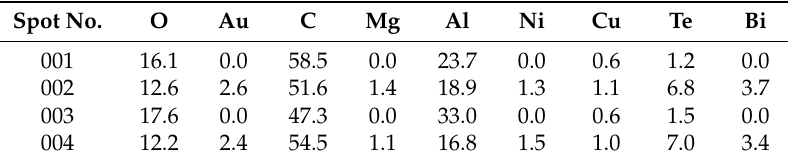
Figure 3. Spot analysis results: ( a ) backscattered electron composition (BES) image of the deposited material on AAO; ( b ) BES image showing the locations for the EDS spot analysis; ( c ) EDS spectrum for Spot 001; ( d ) EDS for Spot 002; ( e ) EDS for Spot 003; ( f ) EDS for Spot 004. Table 1. Mass percentage of elements at the four spots.